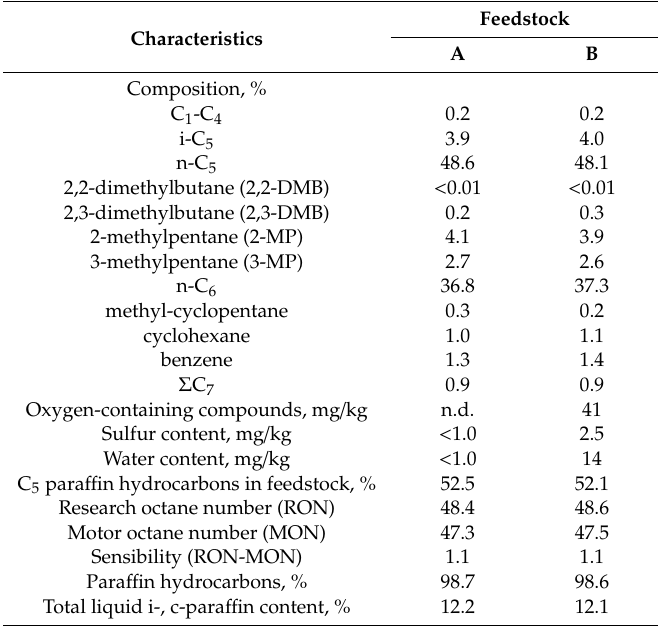
Table 1. The main characteristics of light biogasoline